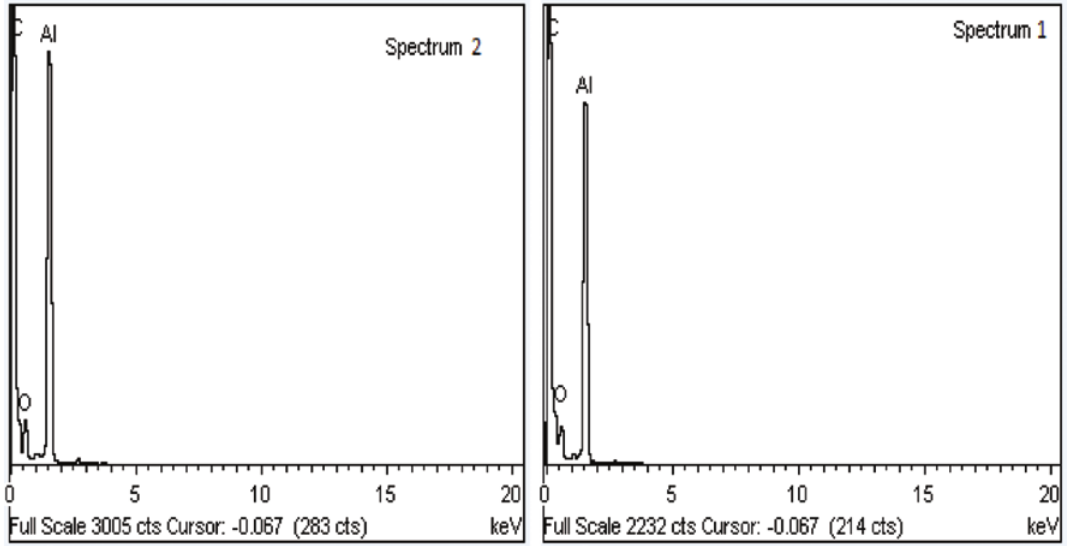
Figure 4: (A) EDAX test report of sample 1 and (B) EDAX test report of sample 2.